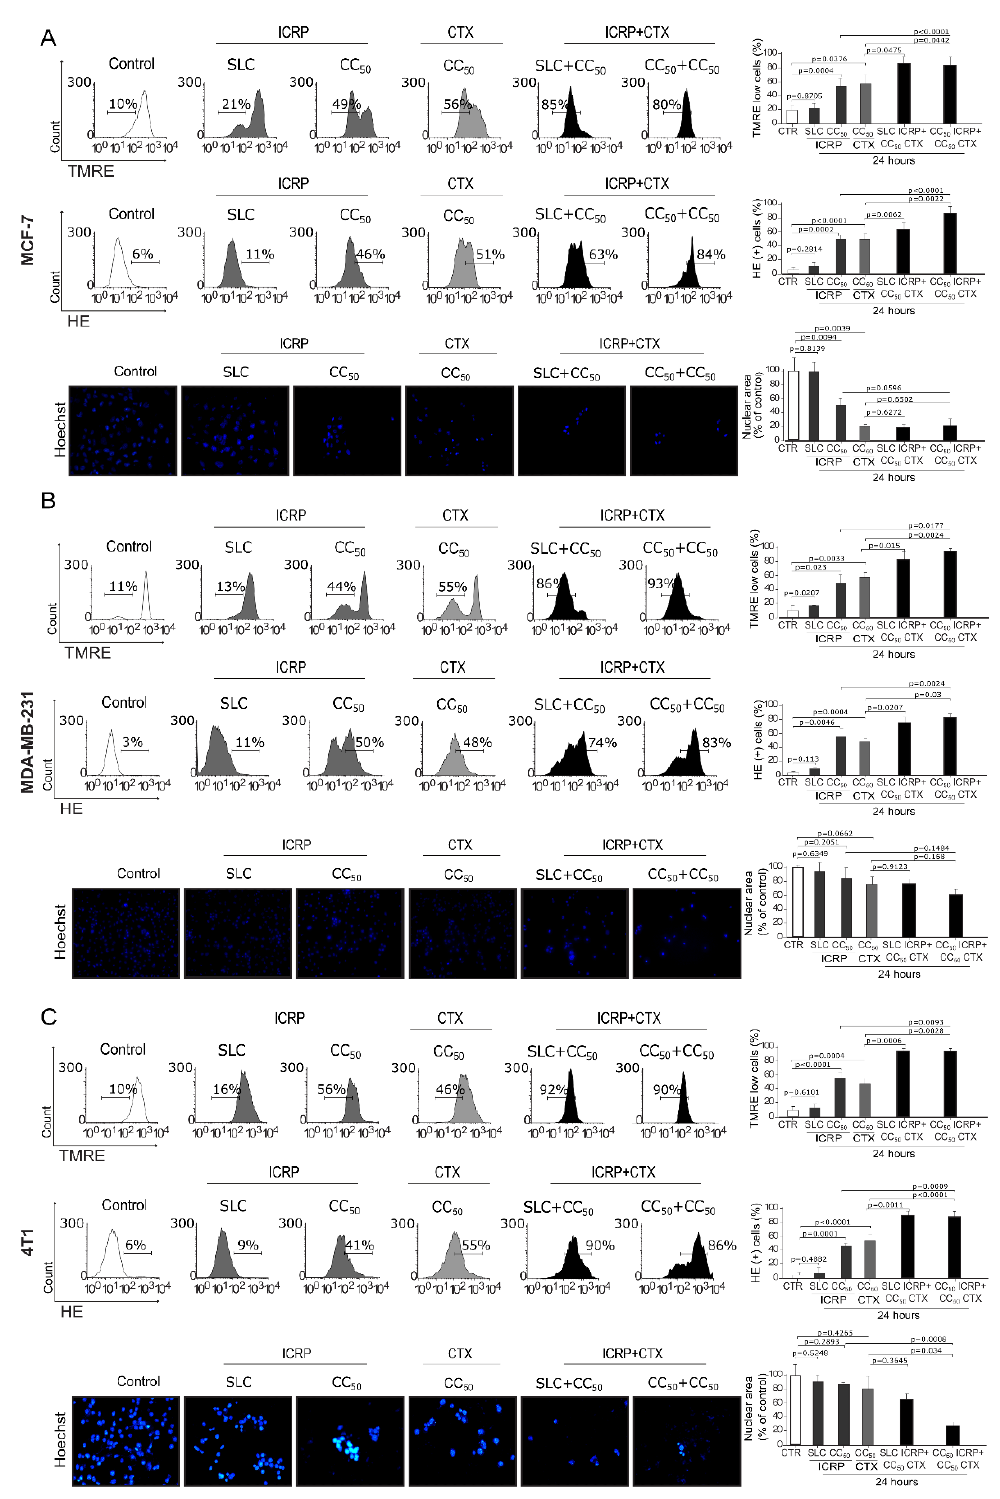
Figure 4: ICRP+CTX cell death causes morphologic and mitochondrial alterations in breast can- cer cells. Cells were treated with the combination of ICRP+CTX in two different ratios for 24 h and analyzed by microscopy or flow cytometry. Representative histograms and graphs from loss of mito- chondrial membrane potential and ROS production determined using TMRE and HE staining, respec- tively. Representative images of chromatin condensation analyzed using Hoechst staining by fluores- cence microscopy in A ) MCF-7, B ) MDA-MB-231 and C ) 4T1 cells. The mean value of at least three independent experiments performed in triplicate ± SD were